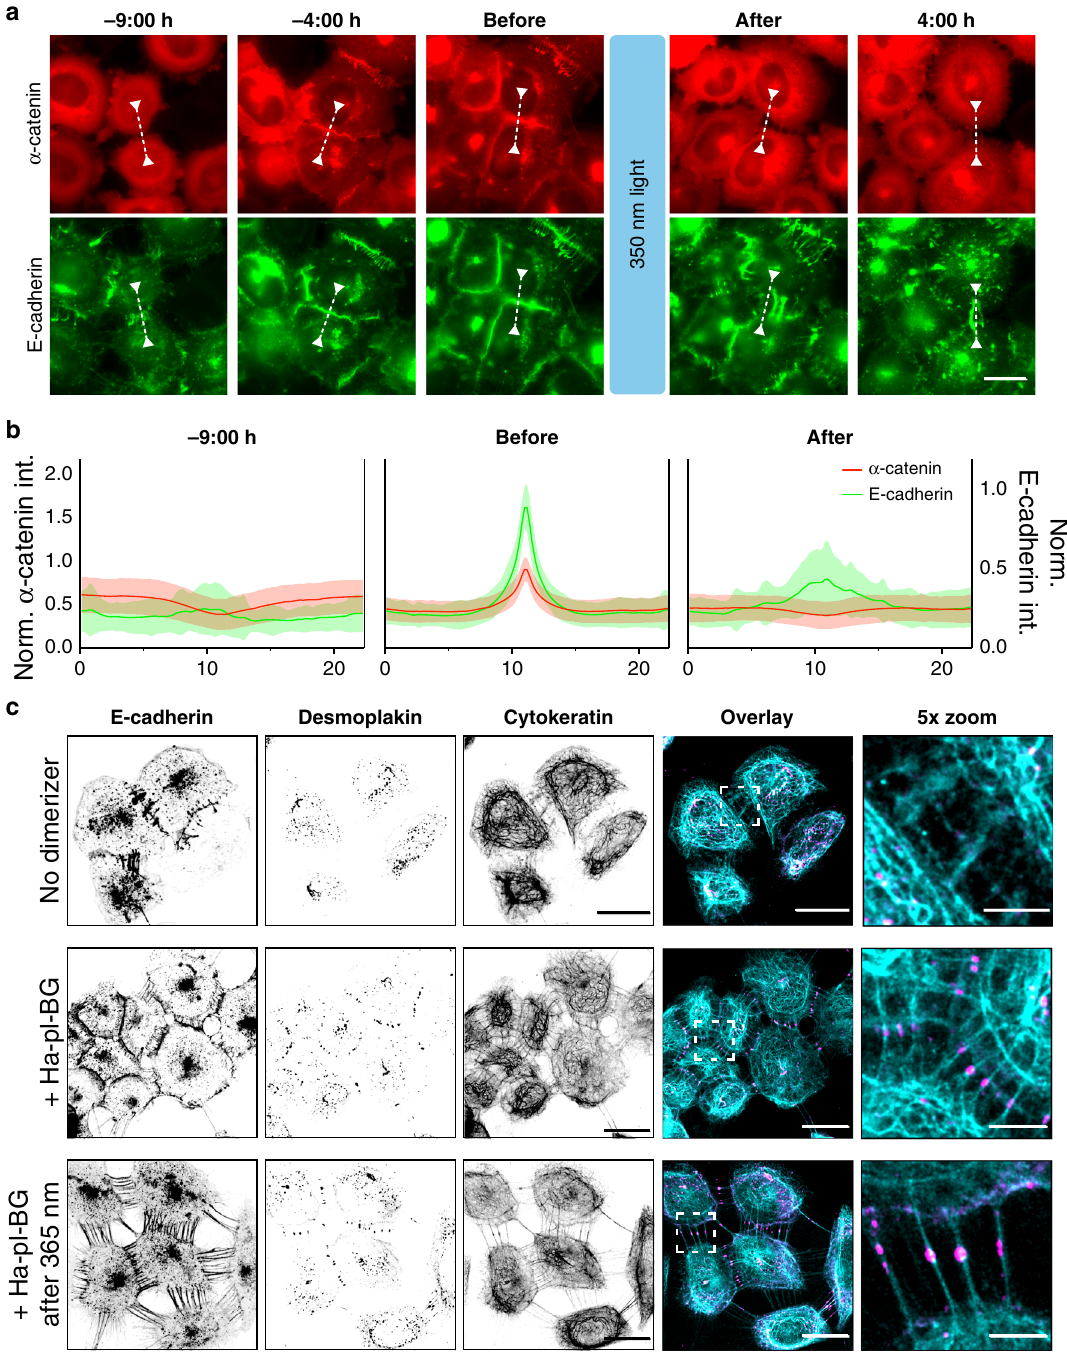
Fig. 4 Dimerizer-mediated reconstitution followed by LInDA to speci fi cally target AJs. a When coexpressed in α -catenin KO cells, the α -catenin (mCherry-labled, shown in red) construct is cytosolic, whereas E-cadherin (GFP-labled, shown in green) is located at the cell membrane forming unstable complexes at cell – cell-interfaces. Following addition of Ha-pl-BG ( − 9:00 h) AJs form ( − 4:00 h) and mature into de fi ned linear structures accompanied by cell compaction (before). After a short pulse of 350 nm light the E-cadherin- α -catenin complex disassembles and α -catenin becomes cytosolic again (after and 4:00 h). E-cadherin clusters destabilize and cells disseminate. Scale bar 20 µ m. b Normalized pro fi les for GFP (green) and mCherry (red) fl uorescence intensity in cross-sections of cell – cell contacts as measures for localization of E-cadherin and α -catenin, respectively. A representative cross-section is shown by the arrow headed dashed lines in a . The lines have been repositioned for each time point to re fl ect pro fi les perpendicular and centered to the cell – cell interface. Mean ± s.d. are shown for n = 45 cross-sections in multiple fi elds of view for each time point. c Staining for desmosome proteins reveals the presence of desmoplakin at cell – cell contacts only in presence of the dimerizer and in cell tethers following the light-induced dissociation of AJs. Scale bar 20 µ m for single color images and overlay image, 5 µ m for 5× zoom